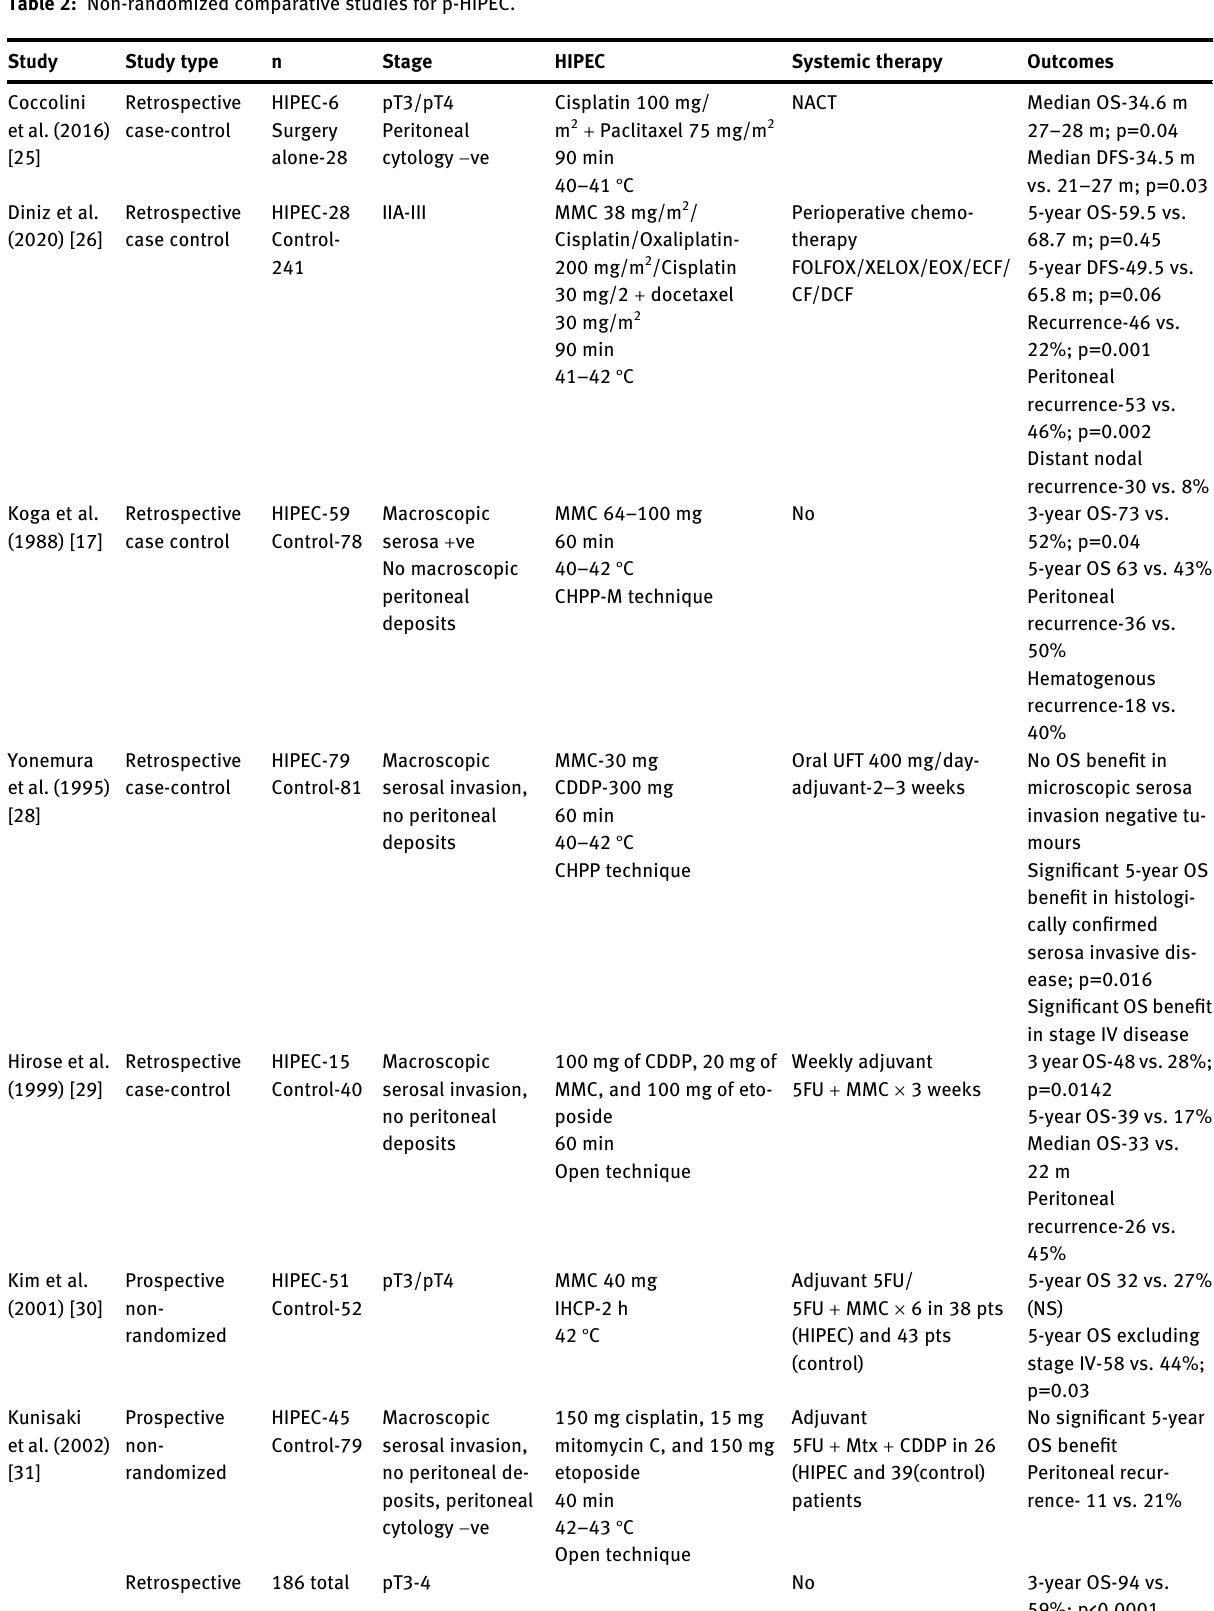
Table  : Non-randomized comparative studies for